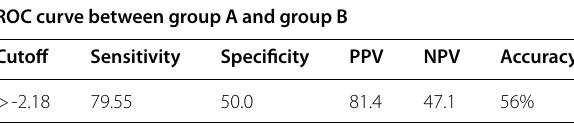
Table 11 ROC curve of NAFLD fibrosis score in prediction